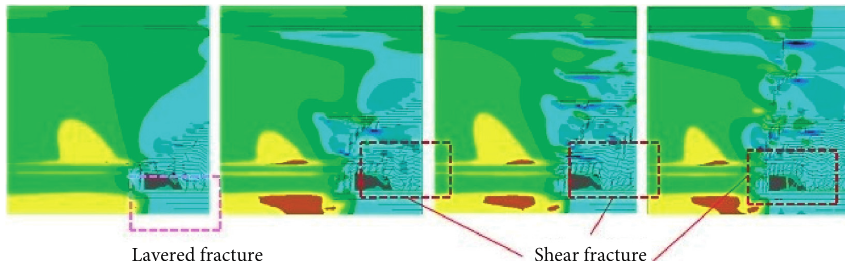
Figure 6: Fracture development in the overlying strata.